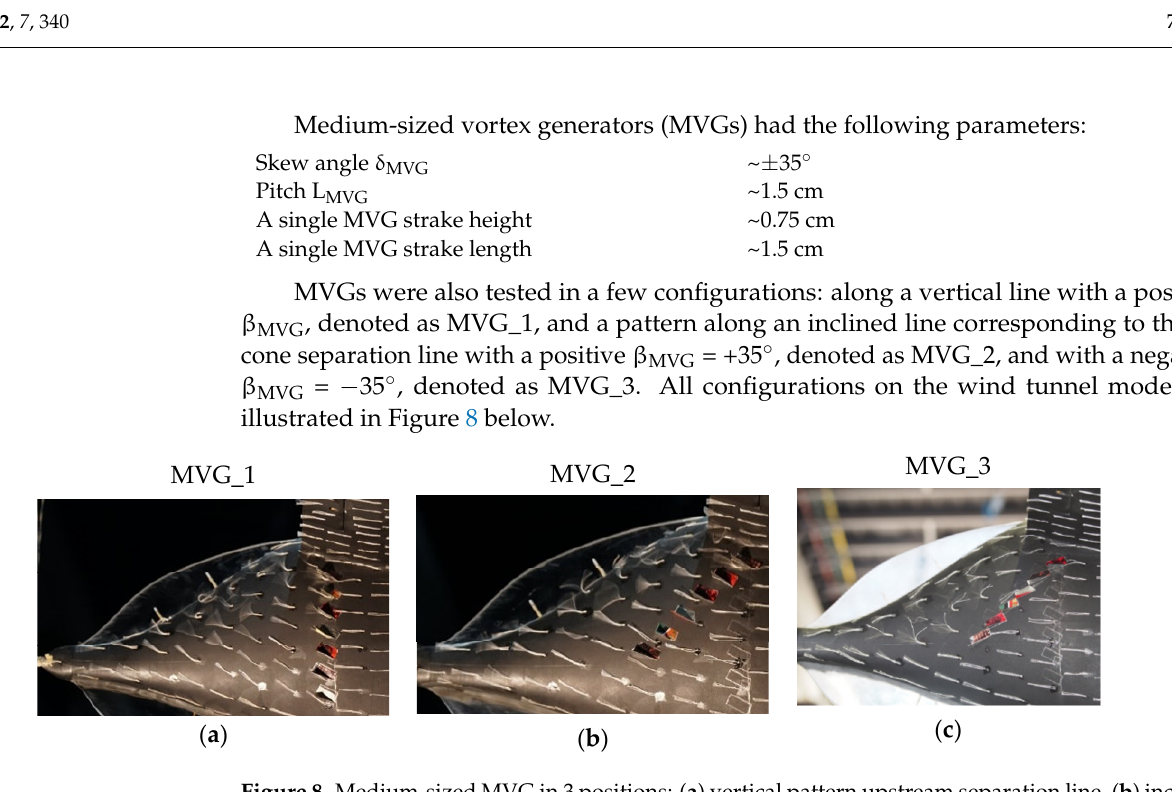
Figure 7. Large vortex generators (LVGs) in positions: ( a ) “1” and ( b ) “2” on the wind tunnel model.